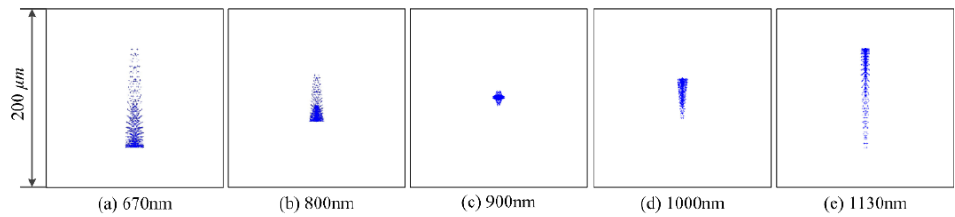
Figure 3. Layout of UTCT, of which the height in sagittal plane is under 2 mm.